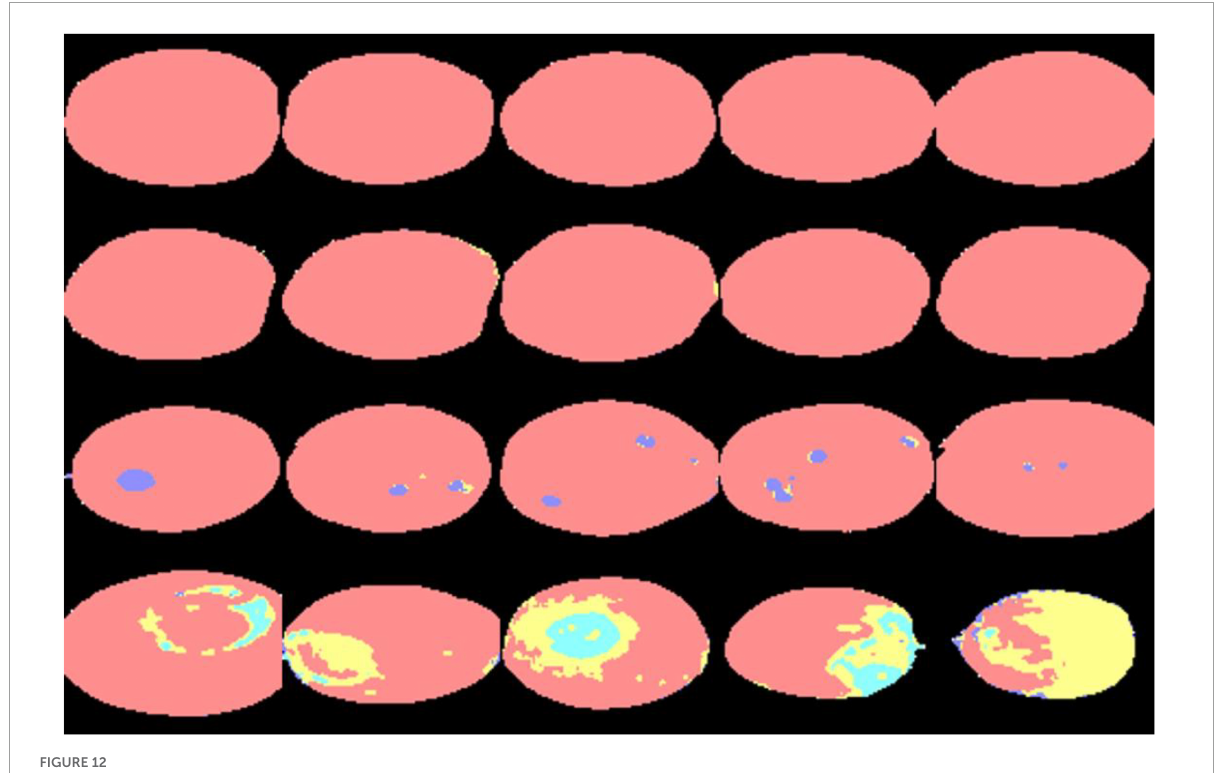
FIGURE12 Discrimination results of 20 navel orange